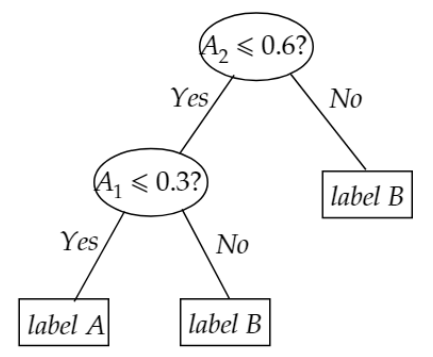
Figure 2. A toy example for evaluating a decision